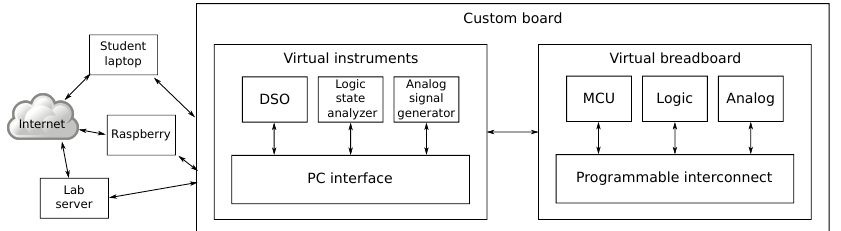
Figure 1. Basic architecture of the